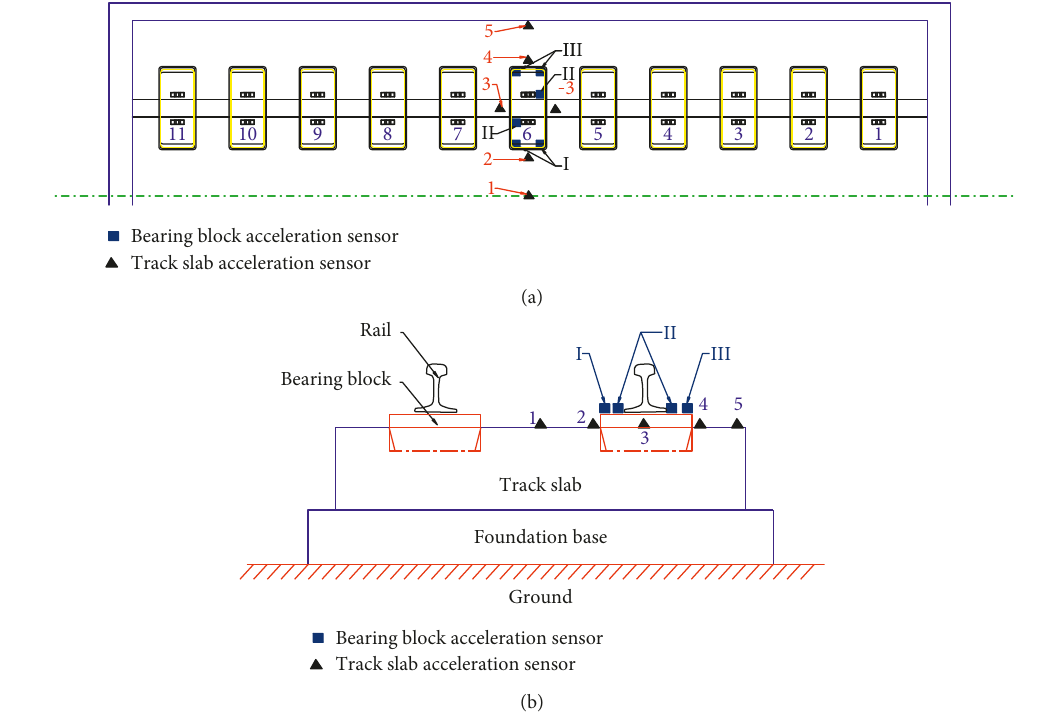
Figure 8: Vertical acceleration sensors arrangement along the track lateral line. (a) Top view. (b) Side